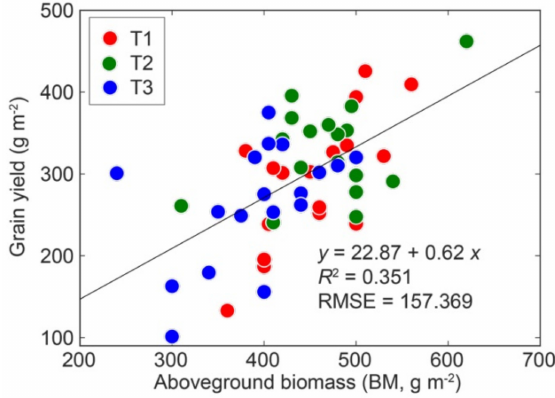
Figure 7. Relationship between BM and grain